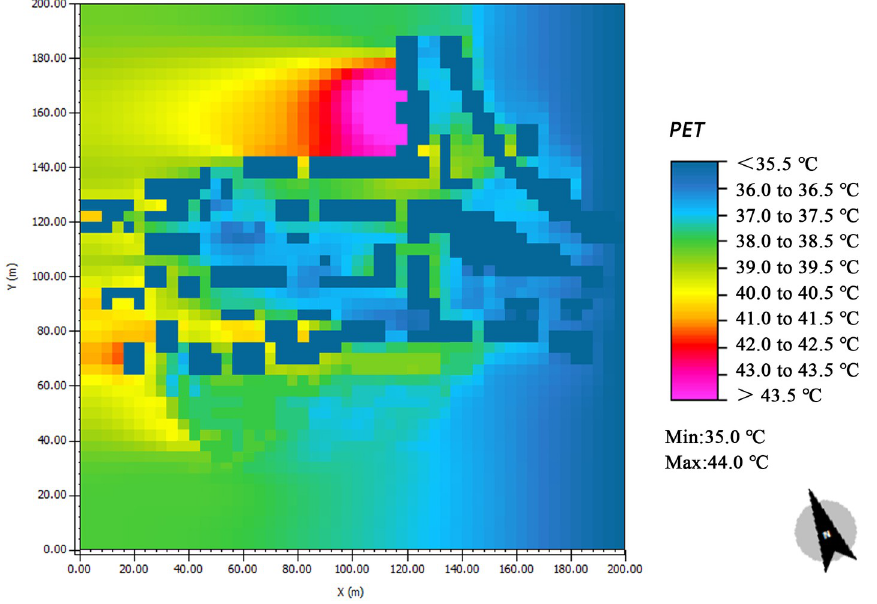
Fig 19. Spatial distribution of PET in the